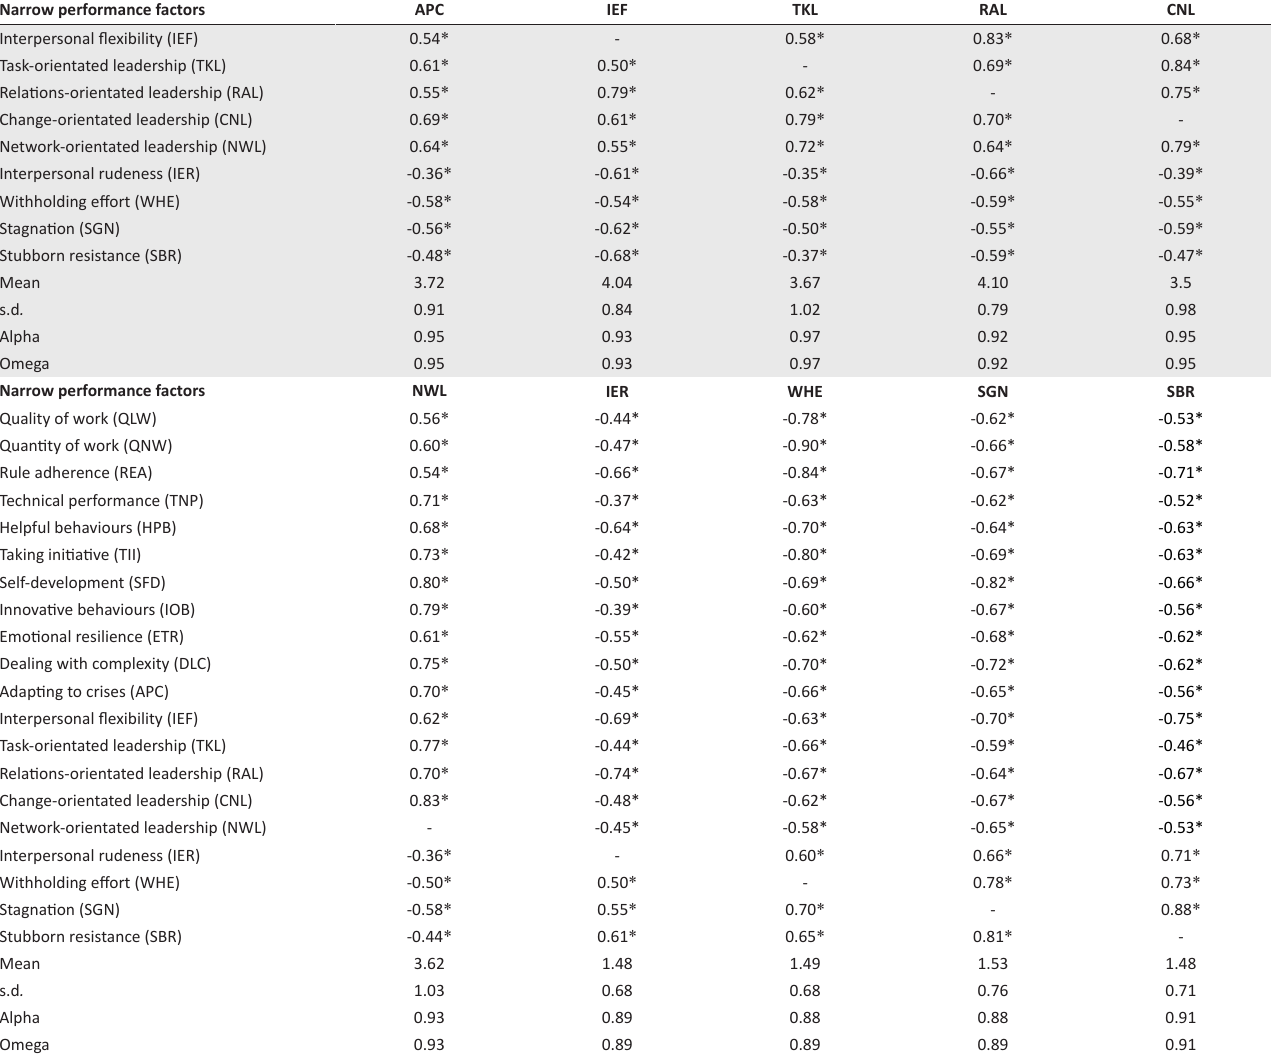
TABLE 1 (continues …): Descriptive statistics for narrow performance factors on the Individual Work Performance Questionnaire. Narrow performance